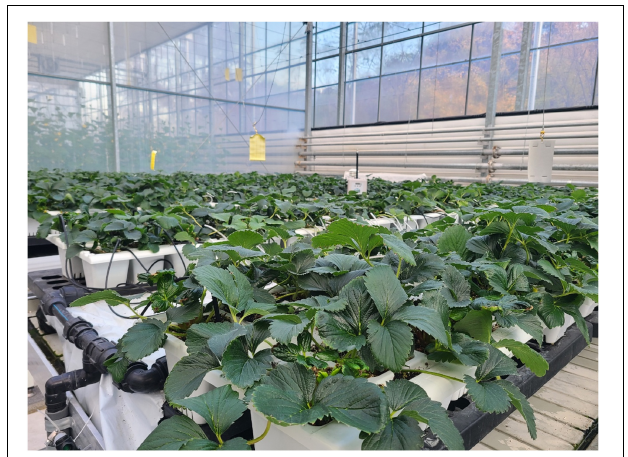
FIGURE 1 | Strawberry cultivation before gray mold disease inoculation.